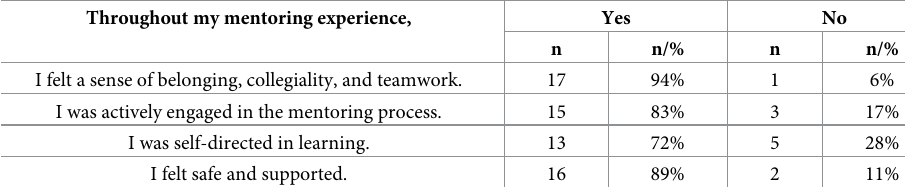
Table 8. Attitudes towards mentoring experience.